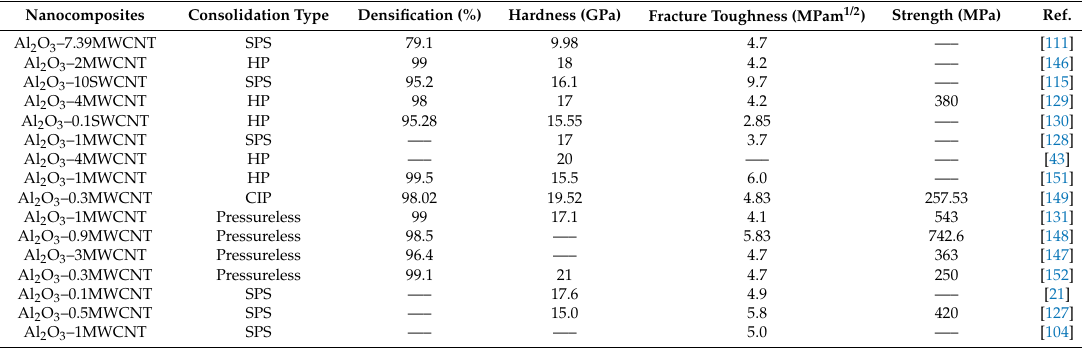
Table 2. Mechanical properties of Alumina-CNT nanocomposites.